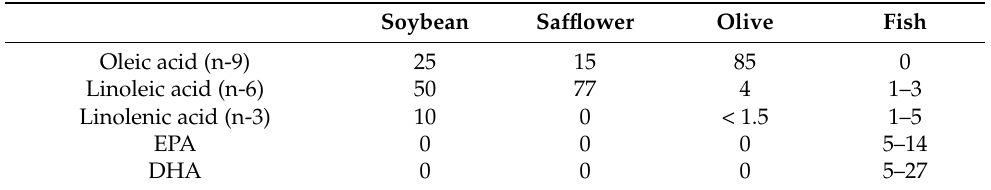
Table 2. Fatty acid composition (%) of various oils commonly employed in parenteral lipid emul- sions [10]. Soybean Safflower Olive Fish Oleic acid (n-9) 25 15 85 0 Linoleic acid (n-6) 50 77 4 1–3 Linolenic acid (n-3) 10 0 < 1.5 EPA 0 0